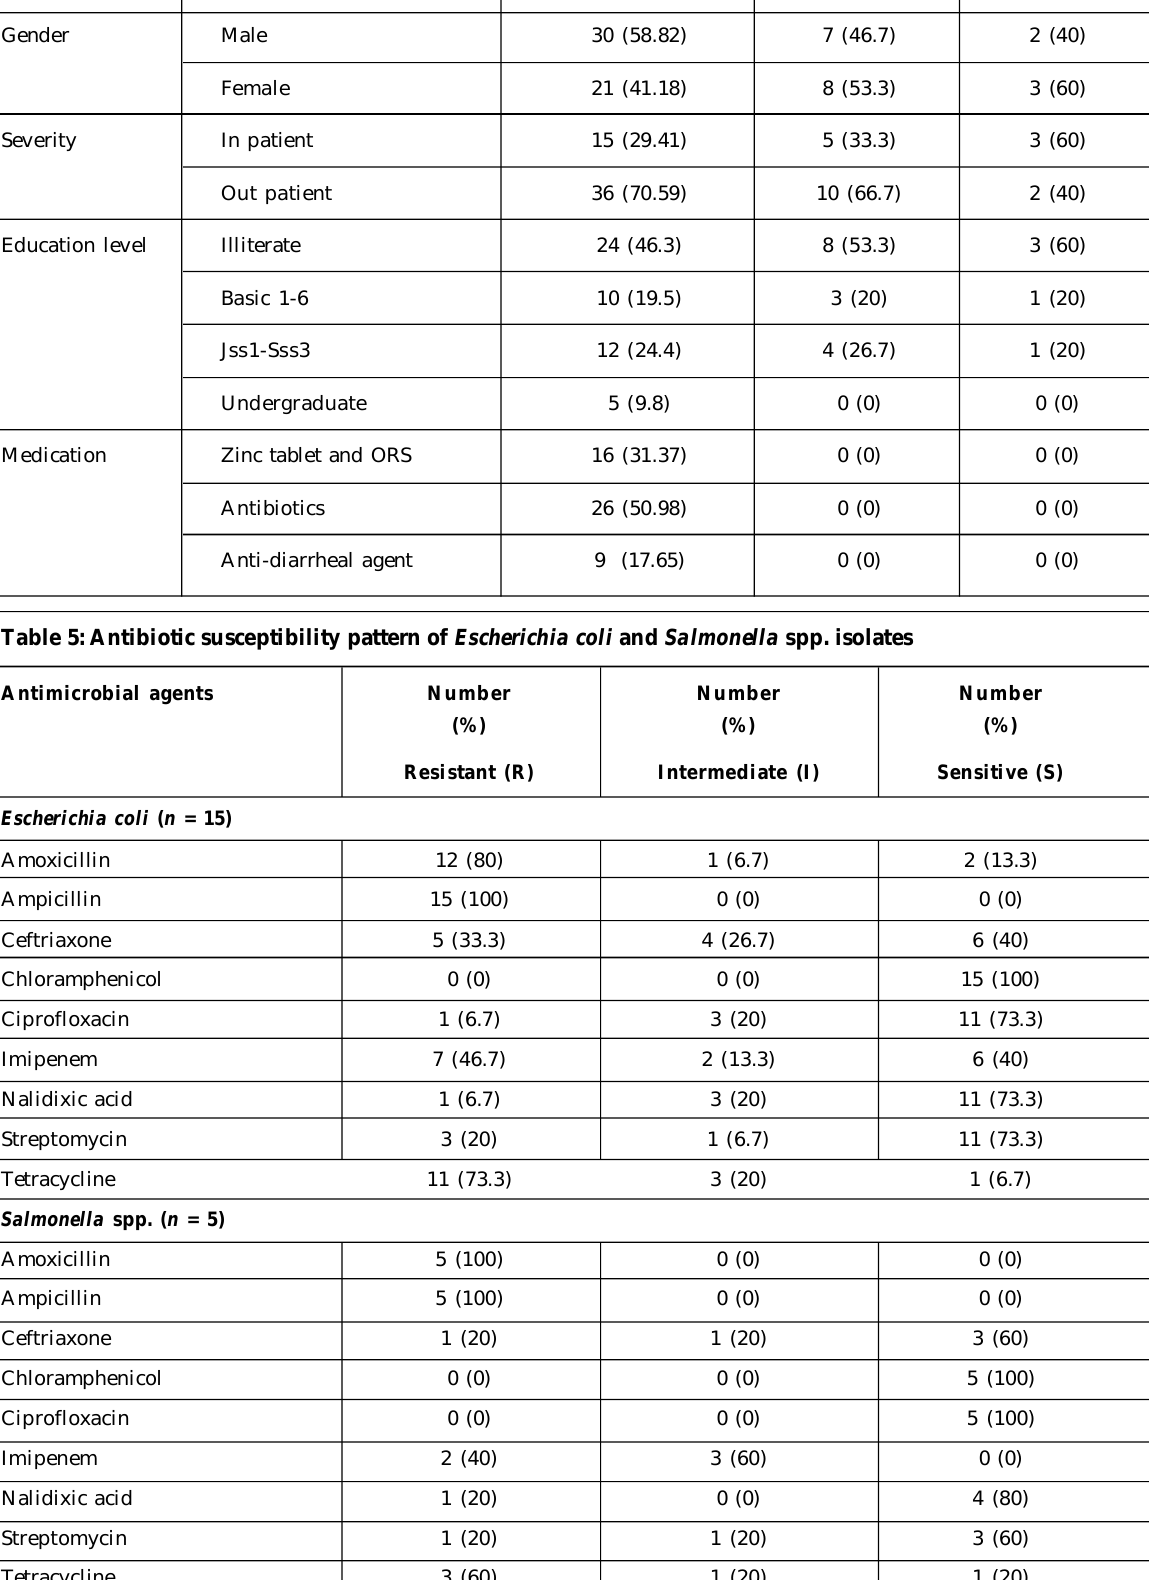
Table 4: Sociodemographic distribution of bacteria isolates of the study participants Frequency number Escherichia coli